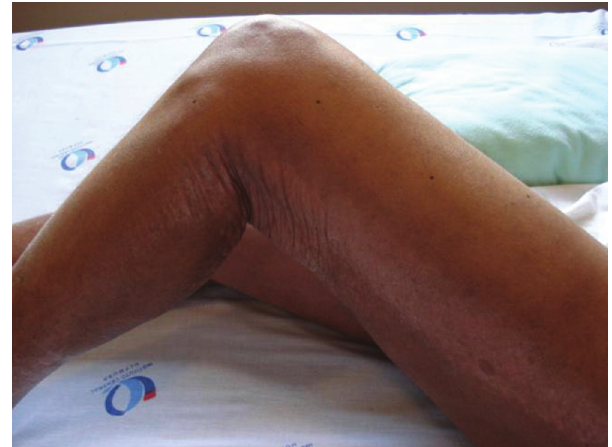
Figure 2 - Band lesion in the left lower limb